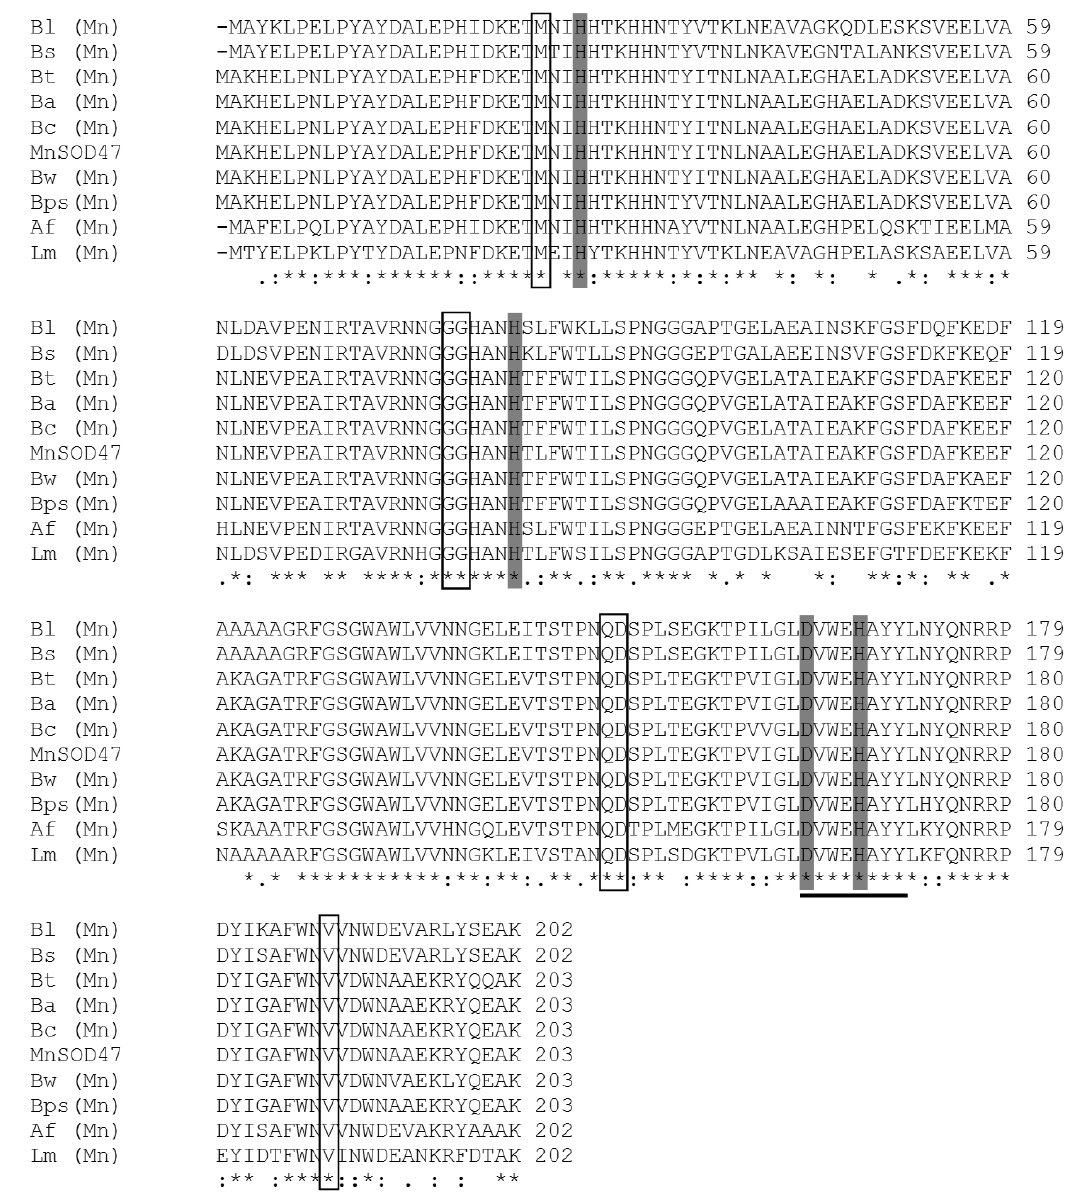
residues highlighted in dark gray represent the four metal-binding sites, which coordinate the metal ion. These residues are conserved in all reported FeSODs and MnSODs. The amino acids characteristic of the MnSODs are boxed [28,29]. The MnSOD signature of the decapod crustaceans (DXWEHXXY) is